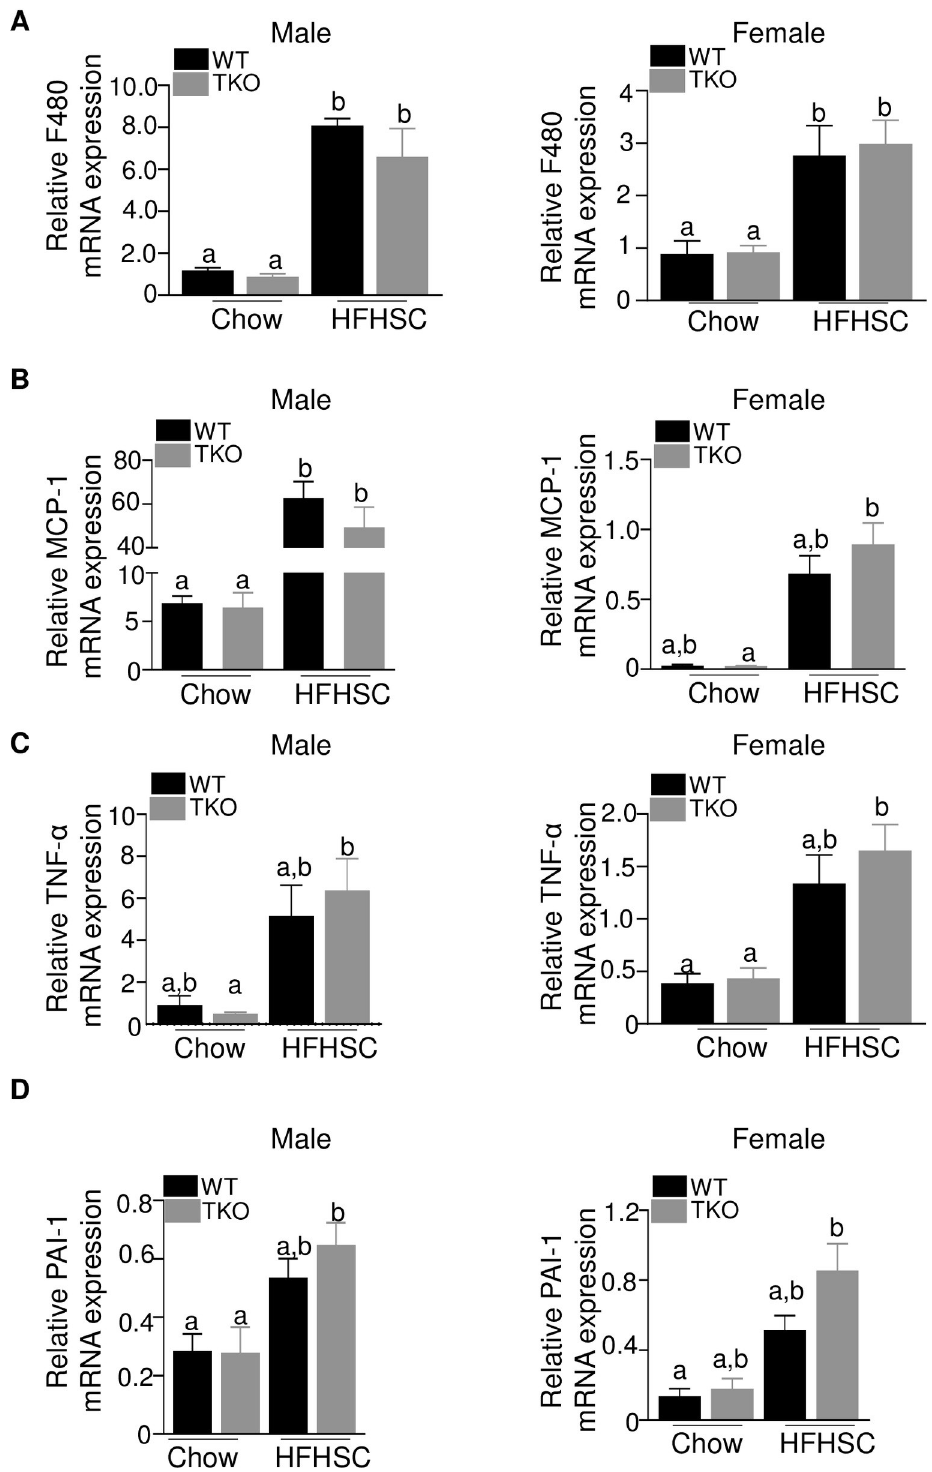
Fig 8. Deficiency of SAA does not affect diet-induced changes in adipose tissue inflammatory status. A-D) Expression of F480, MCP-1, TNF α and PAI-1genes respectively in the gonadal adipose tissues of male and female WT and TKO mice fed either chow or HFHSC diet for 16 weeks (n = 4-10/group). Data are mean ± SEM; data that are not significantly different (P > 0.05) are indicated with the same letter.